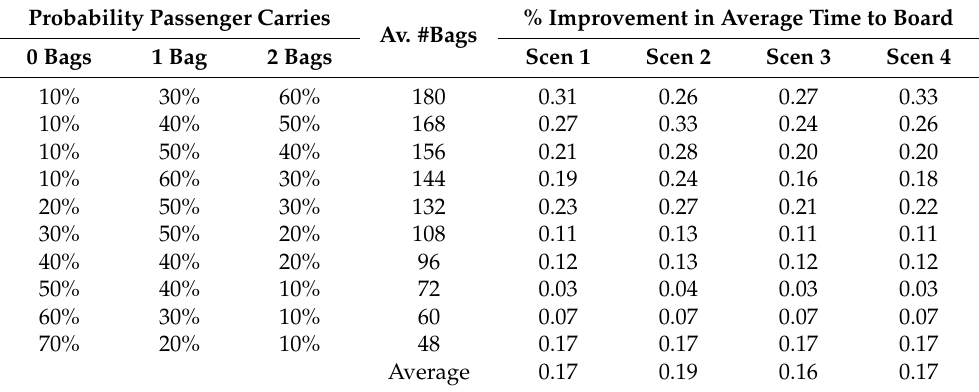
Table 3. Improvement for the proposed method scenarios versus the previous method 1